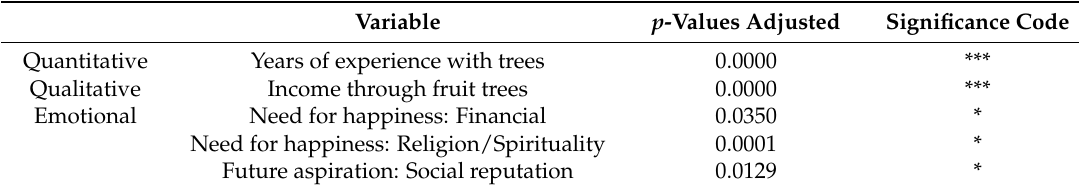
Table 2. Result logistic regression with adjusted p